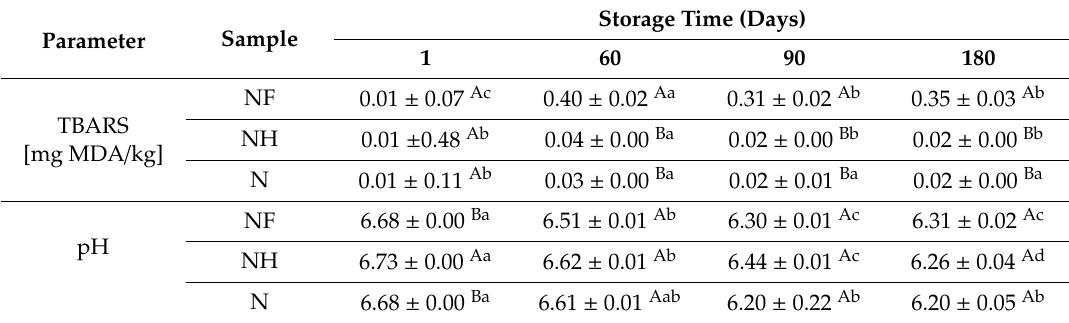
Table 4. Changes in lipid oxidation and pH values of canned meat with reduced amount of nitrite during